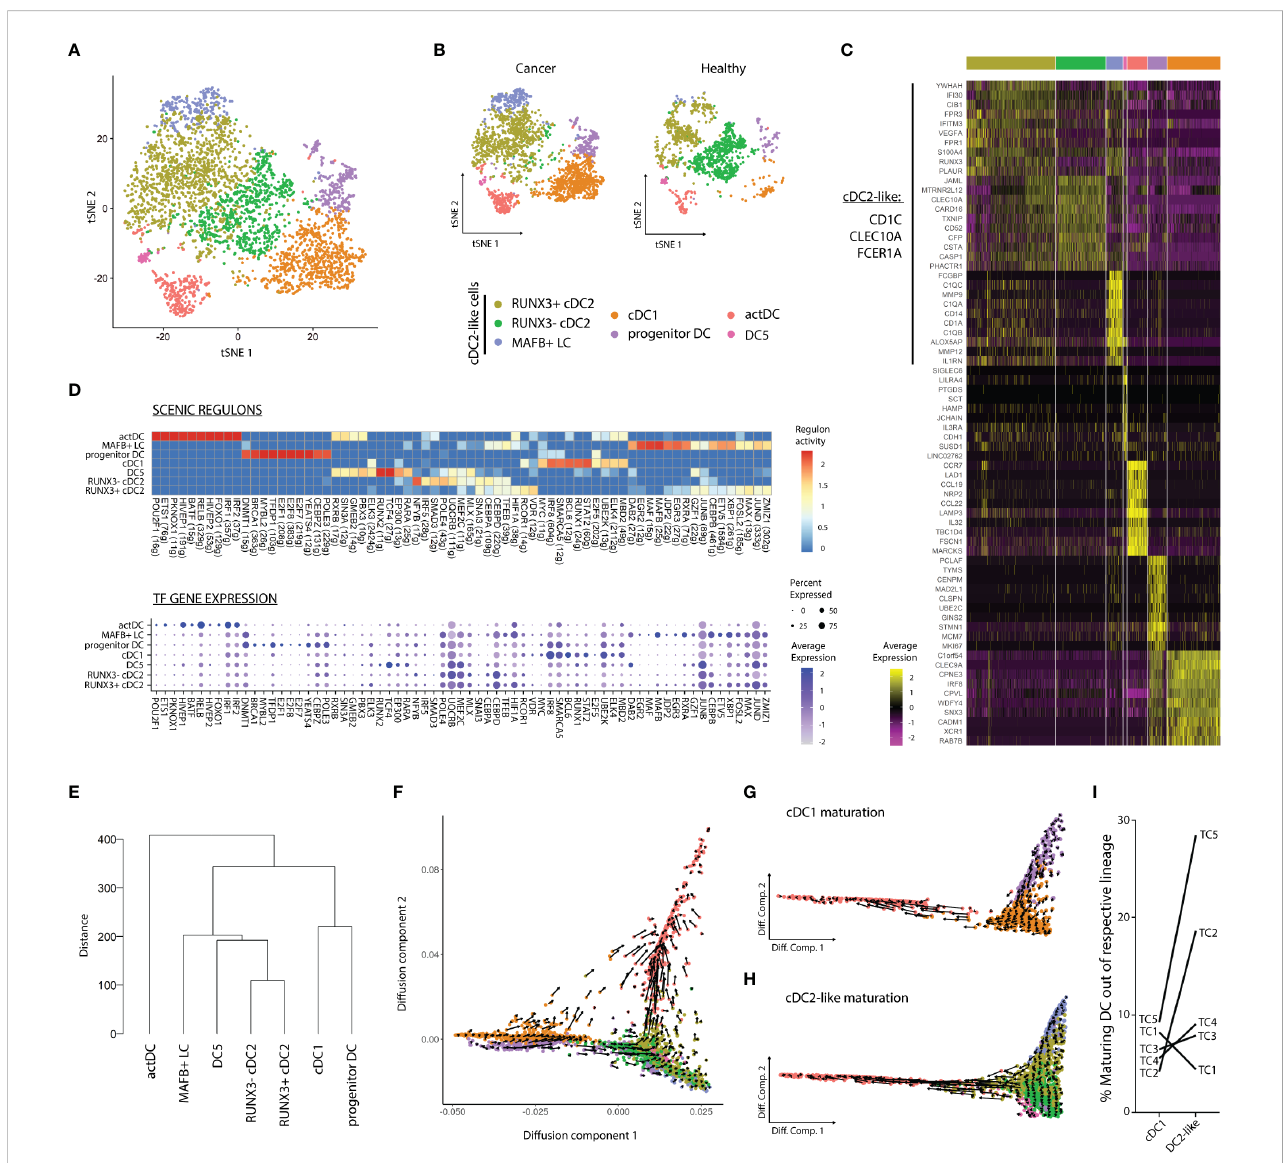
FIGURE 2 Dendritic cell dynamics and activation differ according to the tissue of origin. (A) tSNE plot showing seven distinct DC clusters DC clusters in TC and HT, or (B) separated by tissue of origin. (C) Heatmap displaying top ten DEG per cluster after DGEA (FC > 1.5, p-value < 0.05). (D) Heatmap of the top 10 regulons per cluster colored by regulon activity (upper) and dot plot displaying the gene expression levels of each regulon ’ s TF per cluster (lower). (E) Dendrogram of DC clusters based on the Euclidean distance. Diffusion map combined with RNA velocity analysis to infer the development trajectory of all DCs (F) , cDC1s (G) , and DC2-like cells (H) . (I) Frequency of maturating cDC1s and DC2-like cells annotated by sample of origin, as inferred from RNA velocity analysis. DEG, differentially expressed genes; DGEA, differential gene expression analysis; DC, Dendritic cell; TF, Transcription